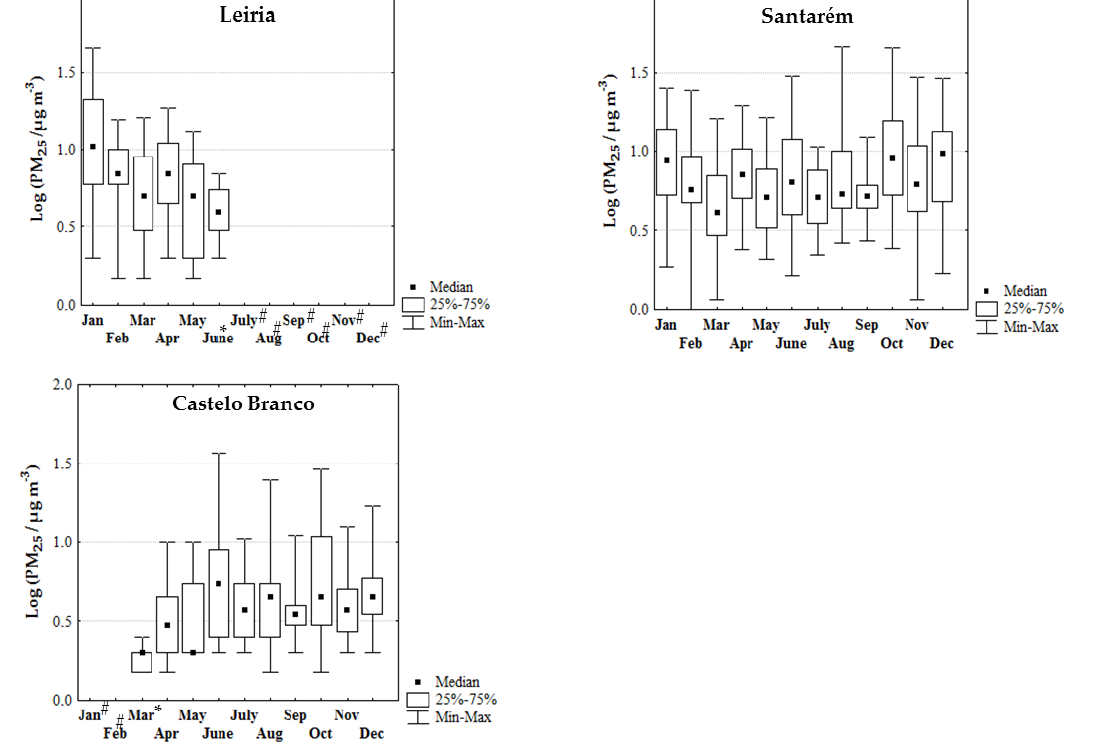
Figure 4. Log-transformed monthly concentrations of PM 2.5 (median, percentiles 25–75, and range; µg/m 3 ) in the rural monitoring stations from the districts in the center region of Portugal. # Data were not available; * data were only available until the 16 June; ** data were only available after the 21 March.